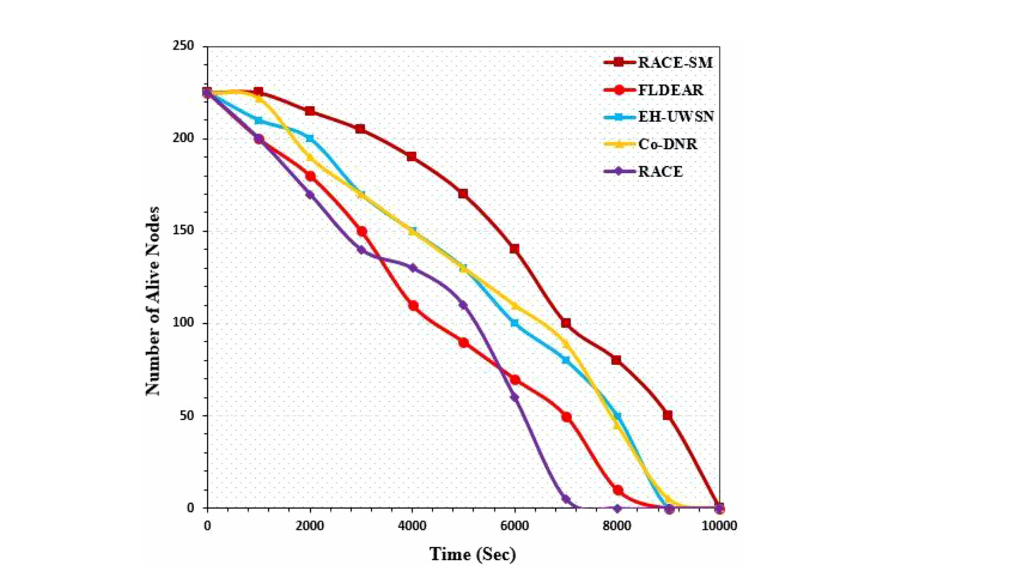
FIGURE 8 Total Number of alive